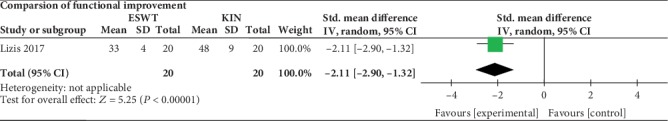
Forest plot comparing the ESWT group with the KIN group.